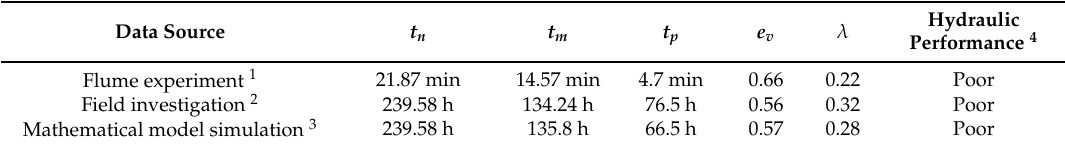
Table 2. Validation of the flume model based on comparisons with the on-site investigation and mathematical model simulation with no obstructions.